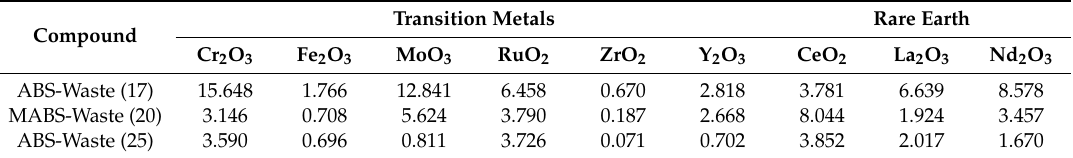
Table 7. Normalized release rate (mg · m − 2 · d − 1 ) for waste components: transitions and rare earth